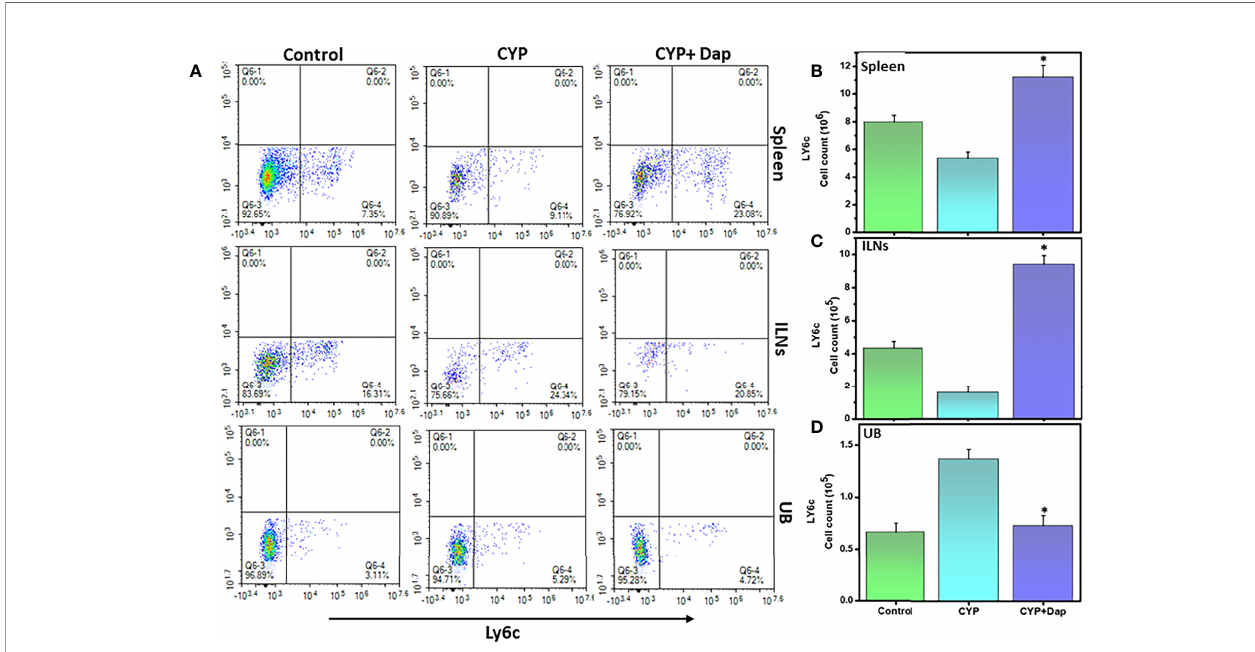
FIGURE 5 | Change in neutrophils frequency after Dap treatment during IC. Single-cell suspensions from the spleen, ILN, and UB were isolated from the three groups at the experimental endpoint, as described in the legend in Figure 2 . Mean values ± SEM from three independent experiments involving six mice per group (n = 18) are shown. (A) Neutrophils were stained for Ly6C expression and analyzed by fl ow cytometry. Density plots are shown with the mean percentage changes (lower right quadrant) and total number per mouse of the Ly6G cells in the spleen (B) , ILN (C) , and UBs (D) . The statistical signi fi cance between the three groups was assessed and asterisks indicate statistically signi fi cant differences between CYP+vehicle and CYP+Dap treatment groups (*p <